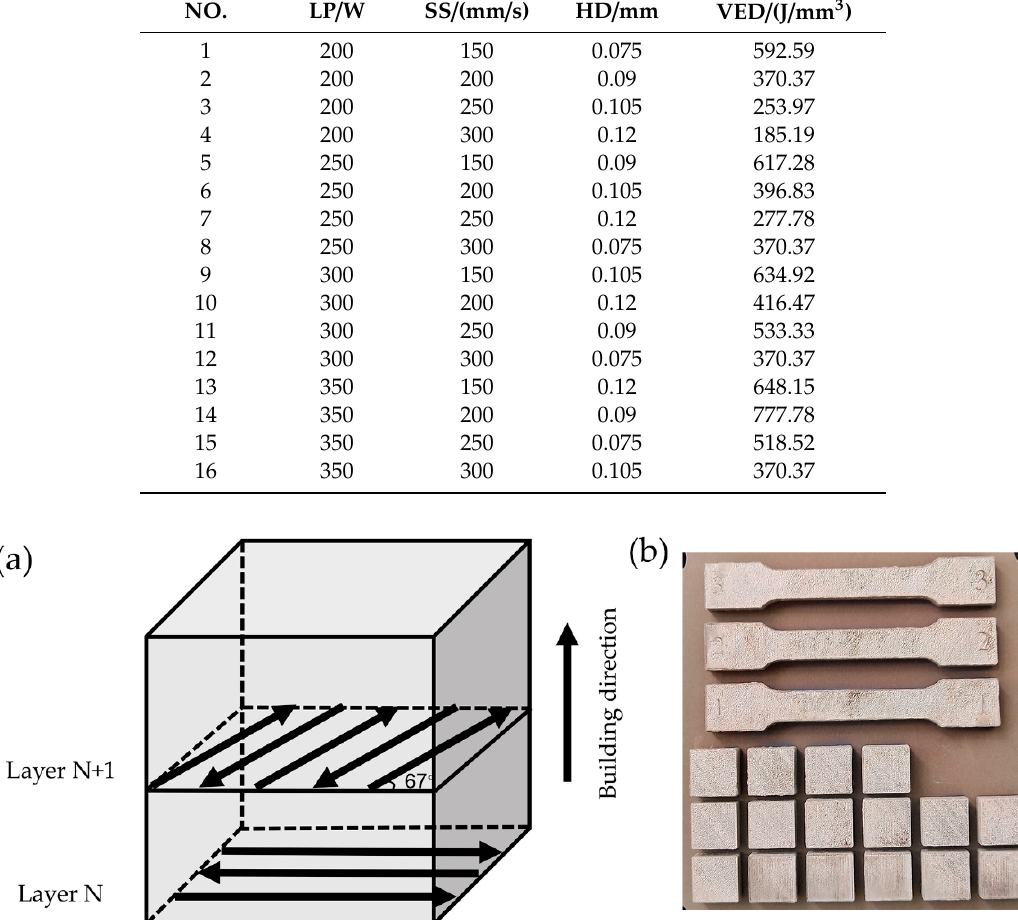
Table 2. Process parameter combinations and the value of the volumetric energy density (VED).